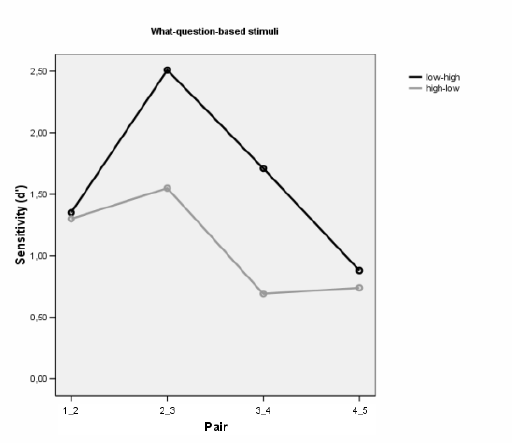
Figure 13. d' calculated for both orders of presentation of pairs from the continuum created from the what- question base